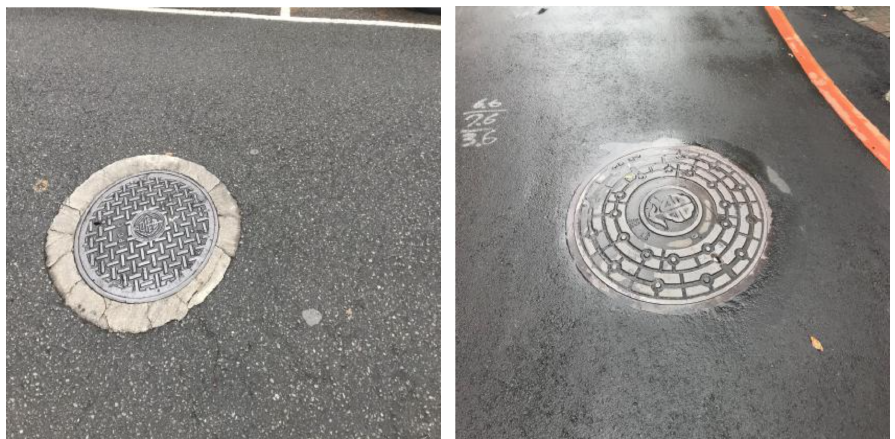
Figure 6. Negative sample: manhole.